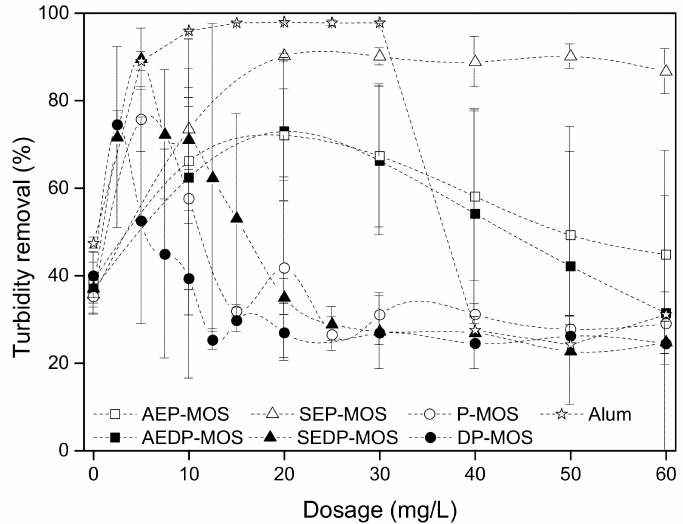
Figure 2. Turbidity removal (%) as a function of Moringa oleifera seed-derived and alum coagu- lants dosages in jar tests after coagulation, flocculation, and sedimentation. Initial turbidity was 200.8 ± 9.3